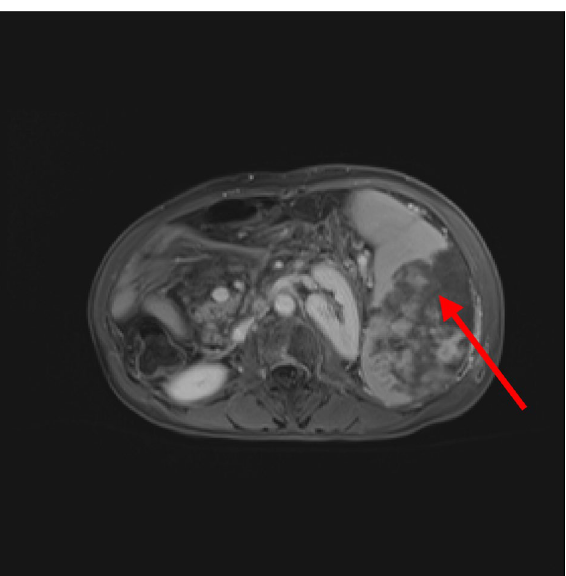
Figure 2. Contrasted MRI showed a patchy nonperfused area of the spleen two weeks after the HIFU treated region of the spleen (red